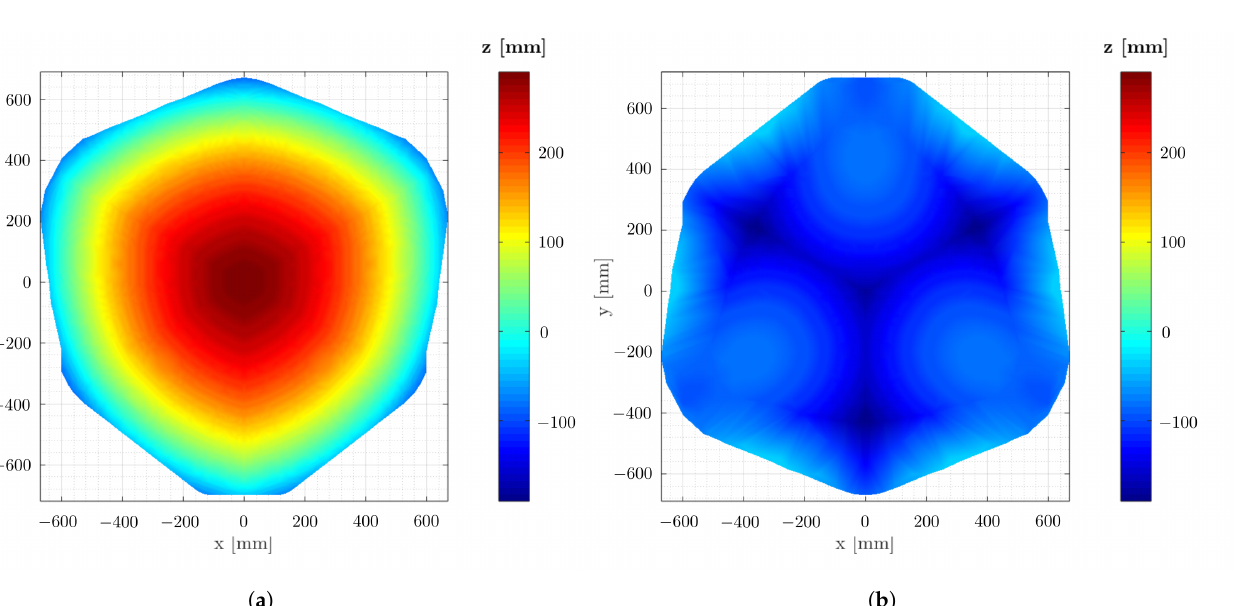
Figure 11. ( a ) Top and ( b ) bottom view of the workspace for zero